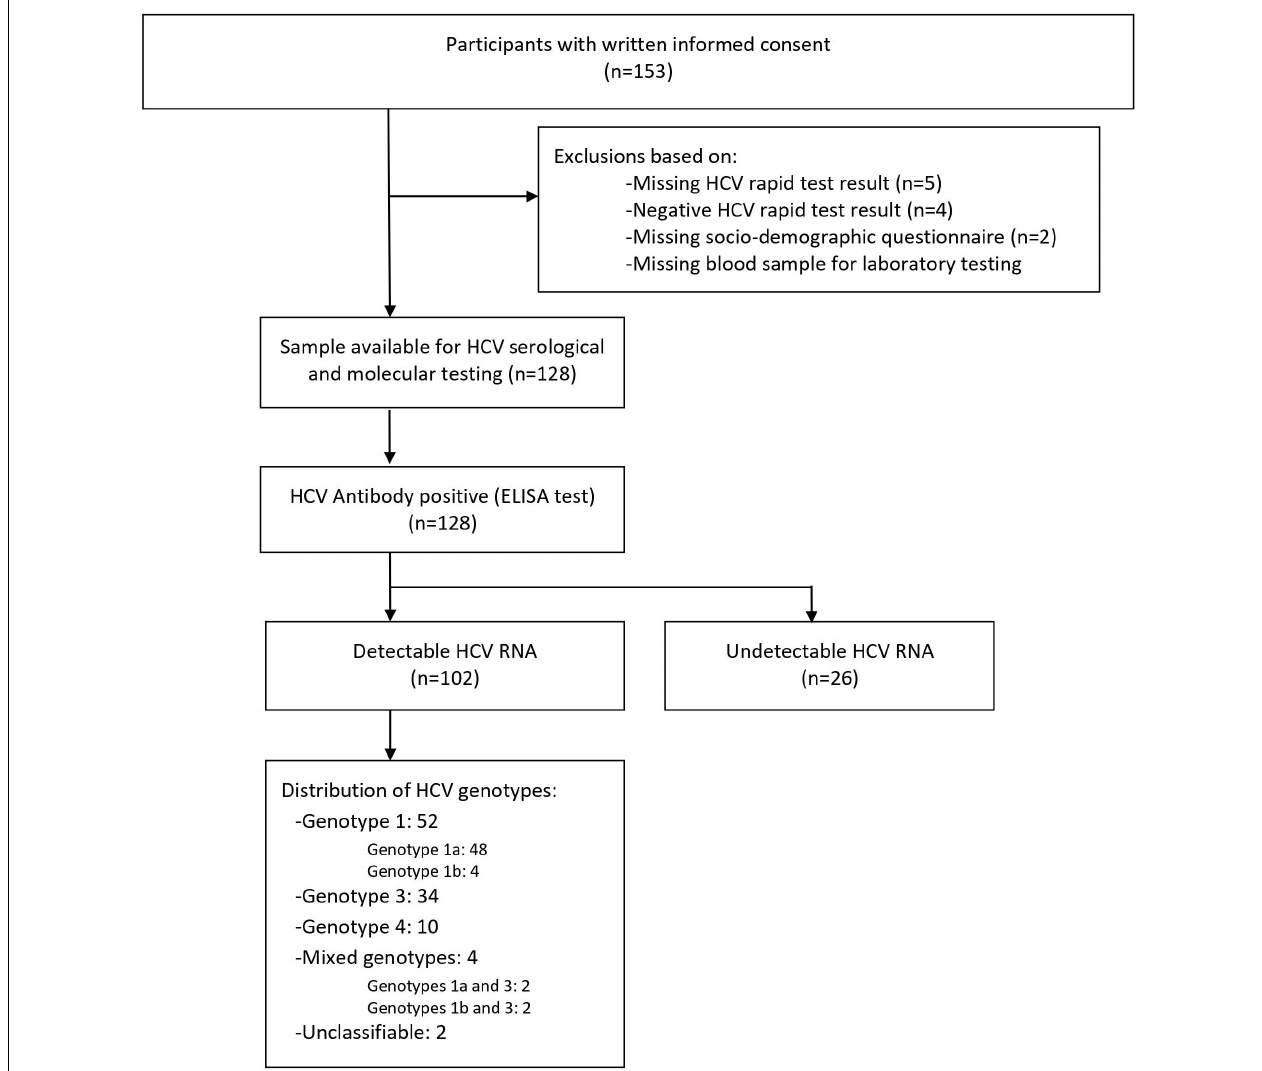
FIGURE 1 | Study flowchart. Overall, 128 participants provided written informed consent. A total of 128 participants had a positive rapid hepatitis C virus (HCV) test and an available sample for serological and molecular testing. All samples with HCV-positive rapid test (100% n = 128) were confirmed positive by HCV enzyme-linked immunosorbent assay (ELISA) test. Among confirmed HCV-positive participants, 79.7% ( n = 102) had a detectable viral RNA. HCV genotypes were identified for 100 people who inject drugs